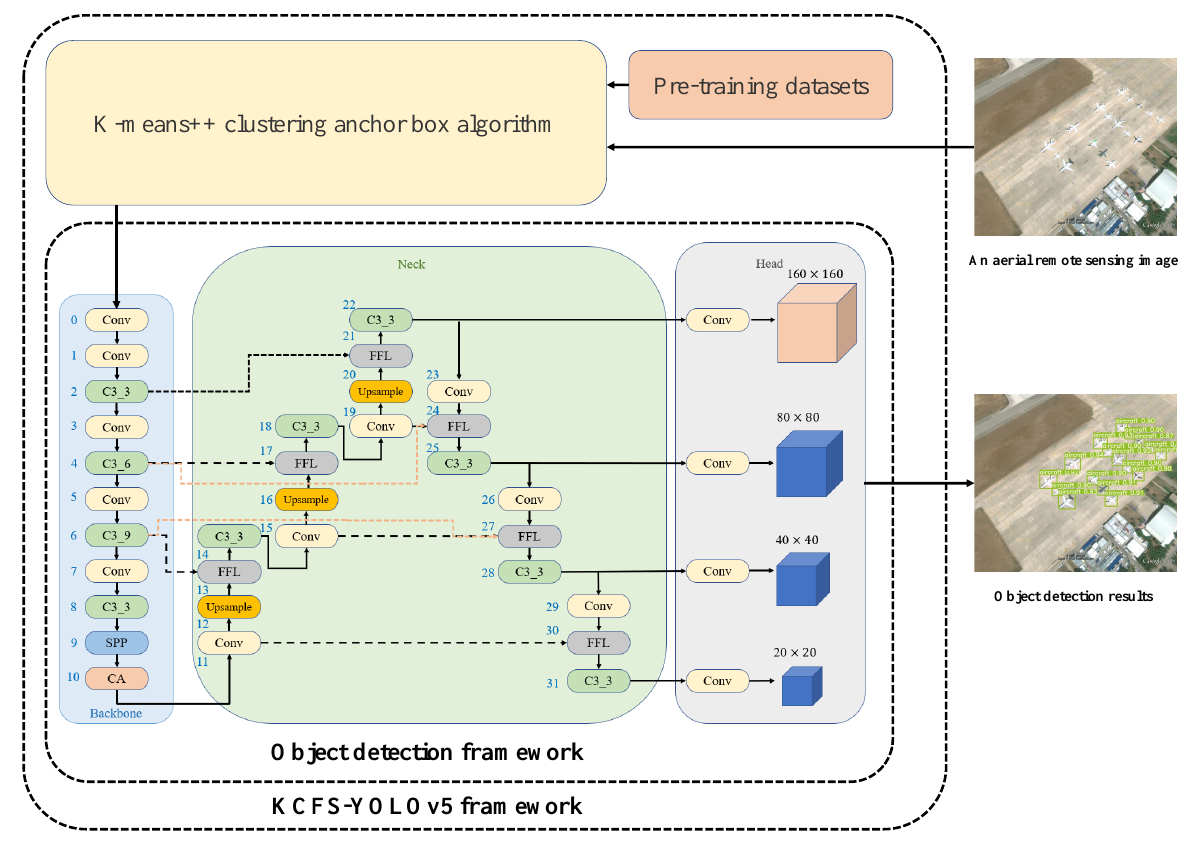
Figure 12. The detection process of